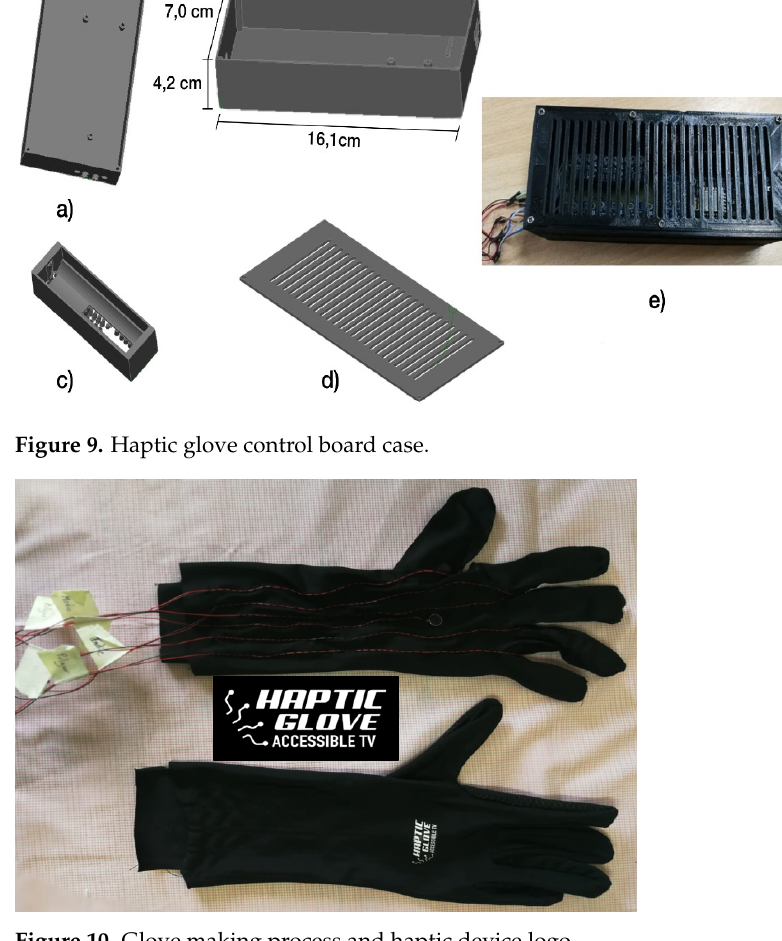
Figure 10. Glove making process and haptic device